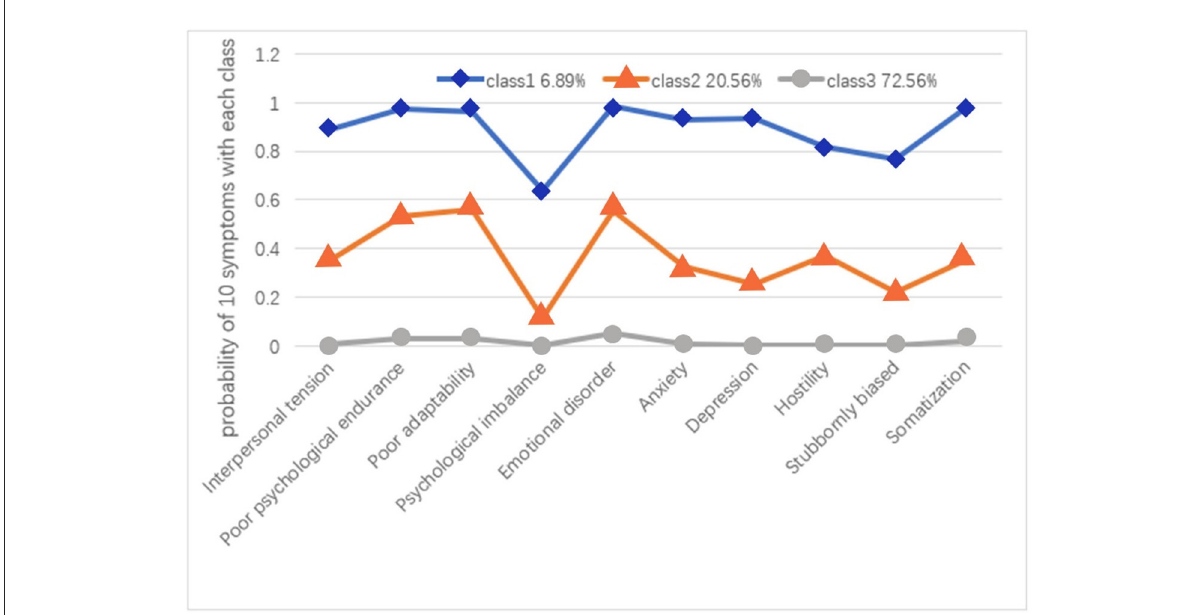
FIGURE1 The three-class model and probability of 10 psychological symptoms within each class ( n = 973). Class 1: the high symptoms group, Class 2: the moderate symptoms group, Class 3: the low symptoms